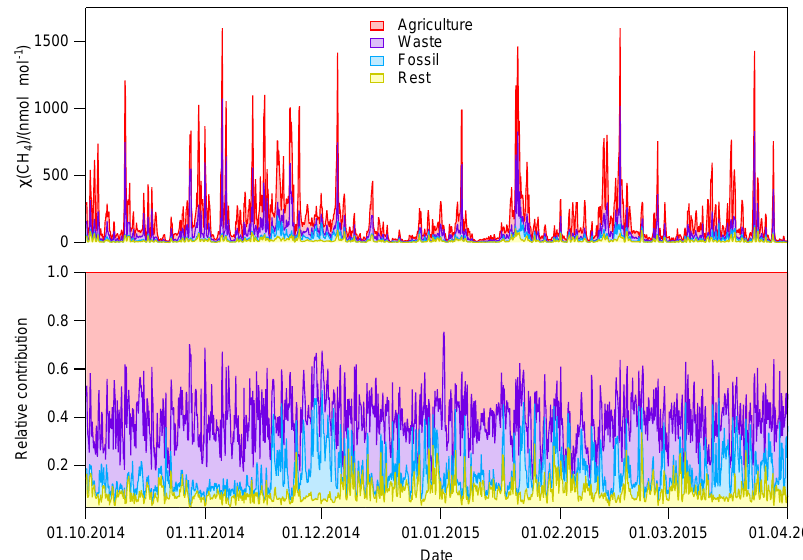
Figure 4. Absolute (top) and relative (bottom) contributions of methane emissions that are picked up along the 4-day FLEXPART-COSMO trajectories during the campaign. The results shown are from the FLEXPART-COSMO simulations with the TNO-MACC inventory. They indicate major contributions of the following source categories: “agriculture” (mainly ruminants), “waste” (mainly landfills) and “fossil” (fugitive losses from coal, oil and natural gas production and from gas transportation and distribution) to the increase in CH 4 mole fractions at Cabauw. The category “rest” primarily represents residential CH 4